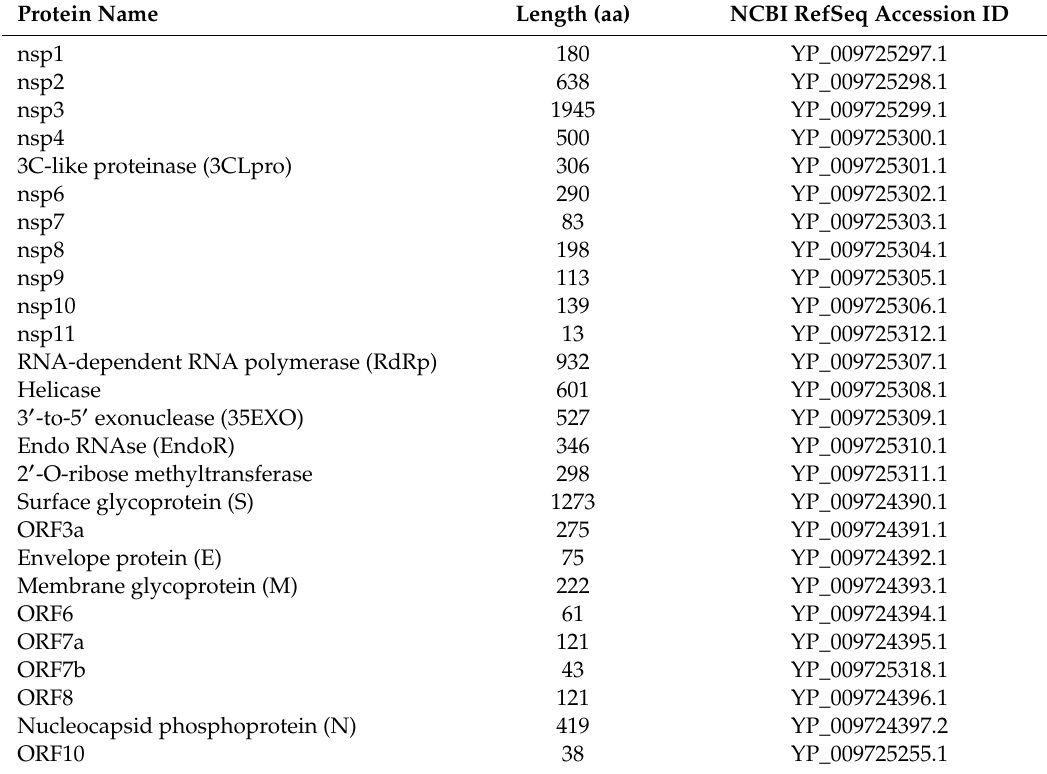
Table 1. SARS-CoV-2 proteins analyzed to predict major histocompatibility complex (MHC) class I binding